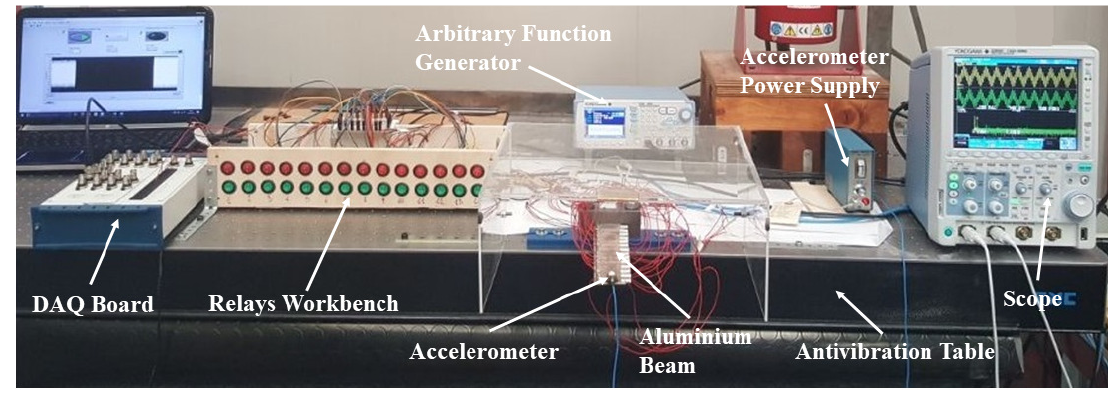
Figure 9. Experimental